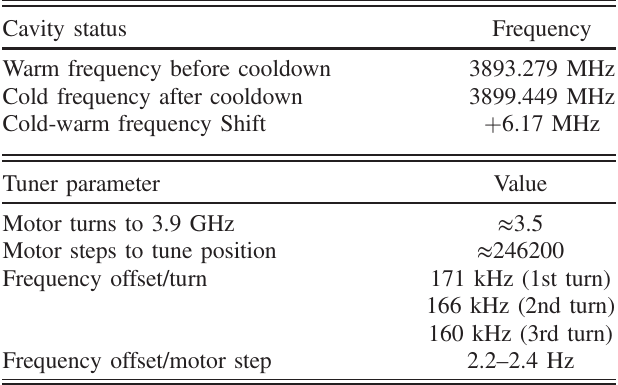
TABLE II. 3HZ010 frequency history and tuner